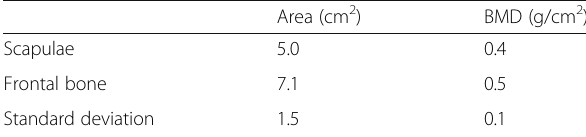
Table 3 Bone mineral density (BMD) measurements of Bos taurus scapulae and human frontal